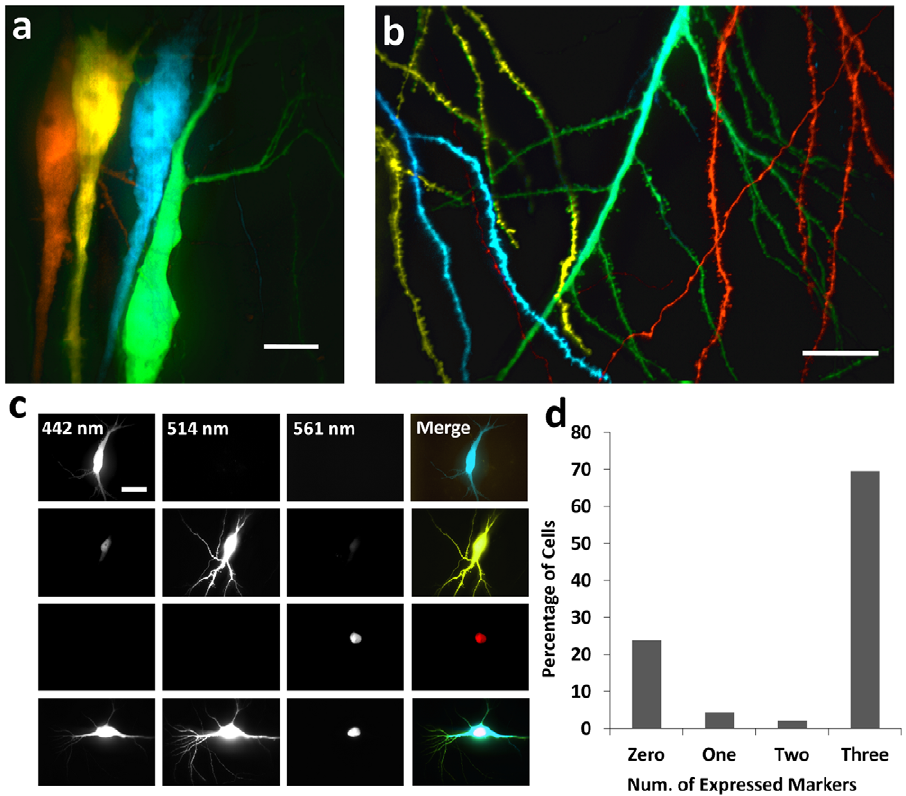
Figure 4. Multicolor Labeling of Single Cells within Brain Tissues and High Co-transfection Efficiencies. (a) Multiple fluorophore- encoding plasmids (pCI-tdTomato, pCAG-YFP, pCAG-Cerulean, and pCAG-EGFP) are transfected into neighboring cells in the same slice. (b) Overlapping processes can be easily distinguished. (c) pCAG-Cerulean, pCAG-YFP, and mCherry-Lac-Rep express three spectrally distinguishable fluorescent markers: cytosolic 442/470 nm (ex/em), cytosolic 514/530 nm (ex/em), and nuclearly-localized 561/610 (ex/em), respectively, as shown